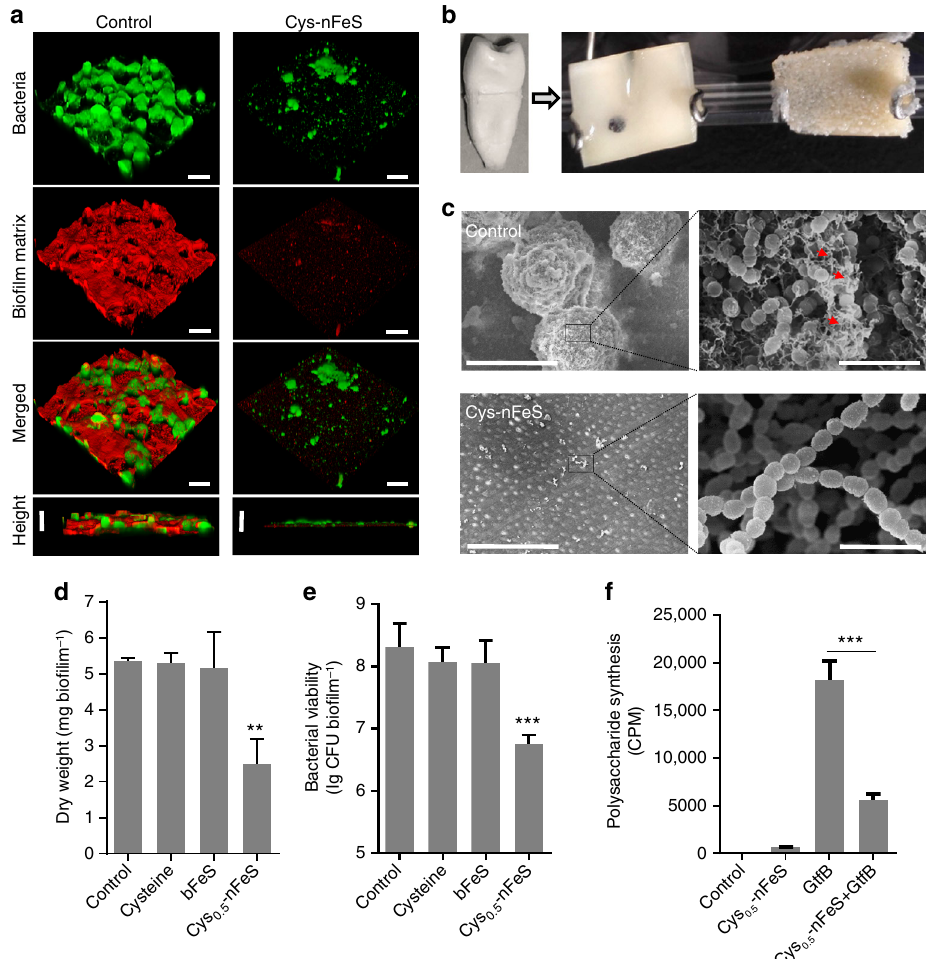
Fig. 4 Bio fi lm elimination on tooth surface using nFeS regimen. a Confocal 3D image of a S. mutans UA159 bio fi lm treated by Cys-nFeS. Scale bars: 100 µ m. b S. mutans bio fi lm formed on a dentin surface sectioned from human tooth. c SEM image of a S. mutans bio fi lm treated by Cys-nFeS. The red arrows indicate EPS. Left scale bars: 100 µ m. Right scale bars: 3 µ m. d , e Dry weight and cell viability of a S. mutans bio fi lm treated with Cys-nFeS. f Inhibition on GtfB activity for polysaccharide synthesis by Cys-nFeS. CPM counts per minute. Data are shown as the mean ± s.d. Statistical signi fi cance was